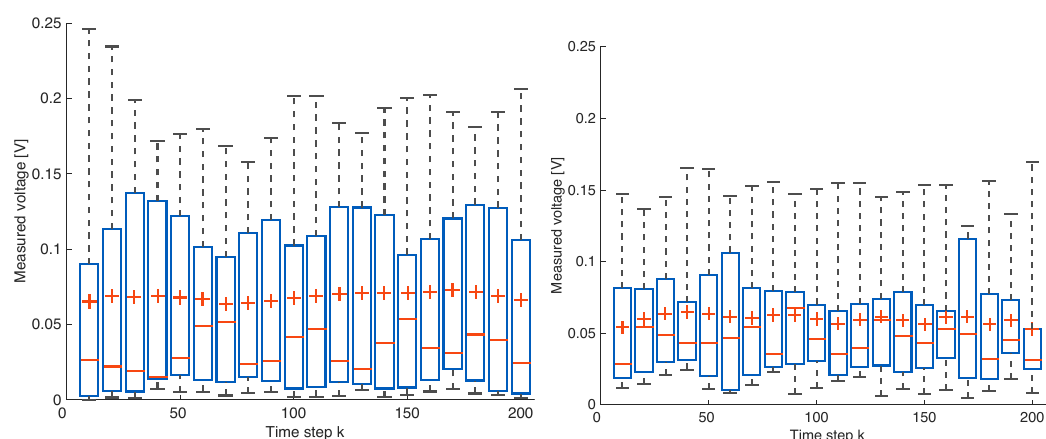
Figure 12. Boxplot illustrating the experimental results of measurements along the paths in a set of 20 positions inside the test area. The results of the test performed with the initial orientation of transmitter coil a = 0, b = 0 and c = 1 are shown in the figure on the left and those with the initial orientation a = 0.72361, b = − 0.52573 and c = 0.44721 in the figure on the right. In each box, the central mark is the median, the box edges denote the 25th and 75th percentiles, and the top and bottom ends of the dashed lines are the maximum and minimum values, respectively. The cross denotes the mean.